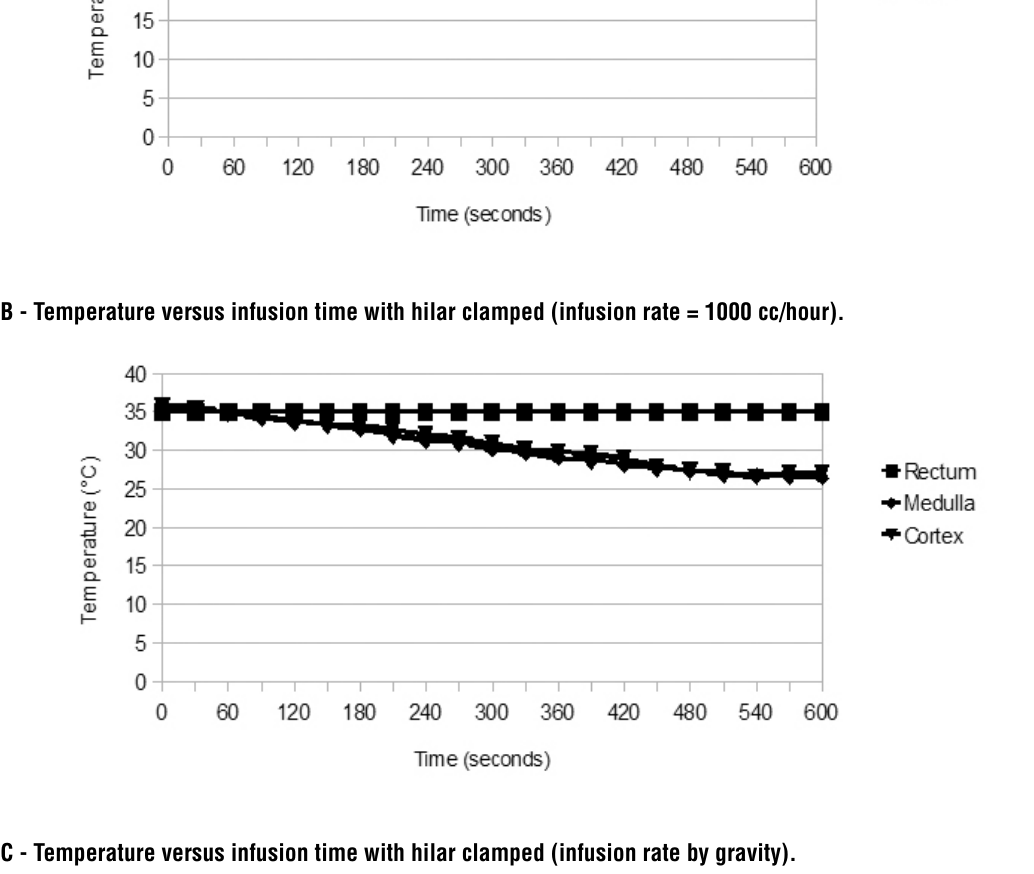
Figure 3C - Temperature versus infusion time with hilar clamped (infusion rate by